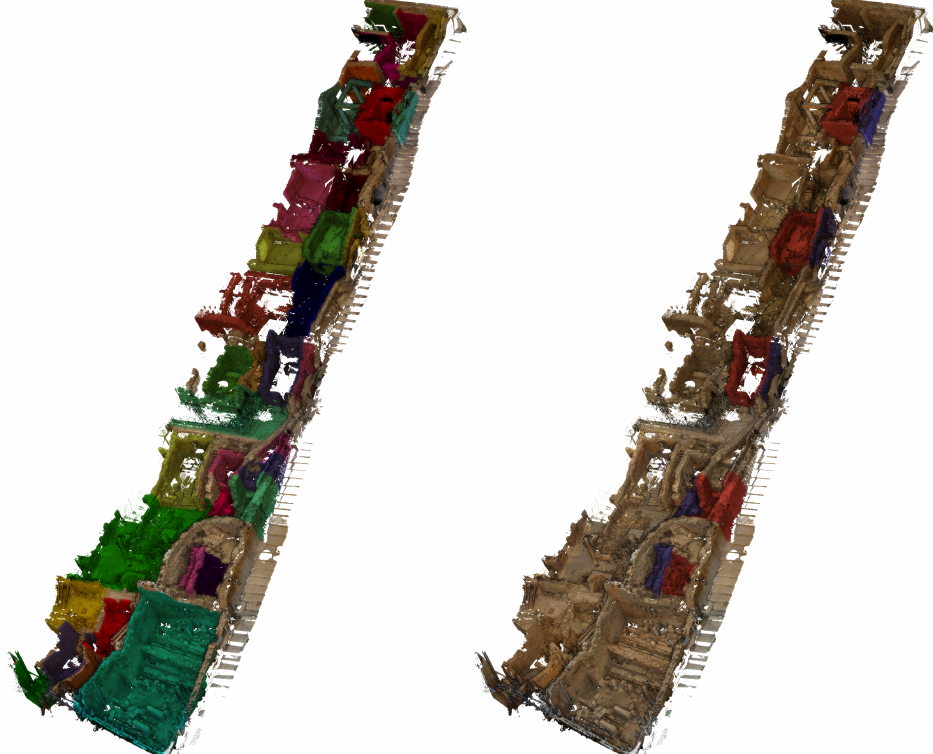
Figure 9. Object recognition results in Ephesos terrace house 2 point cloud: ( a ) room recognition and